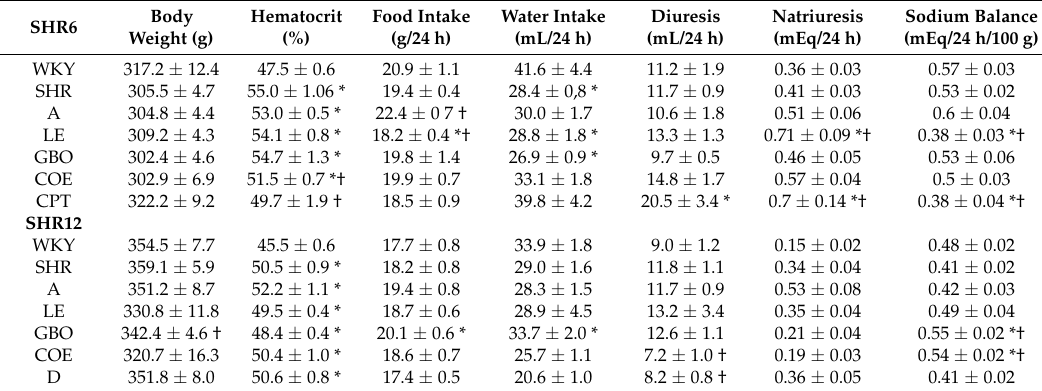
Table 3. Metabolic values in the experimental groups.